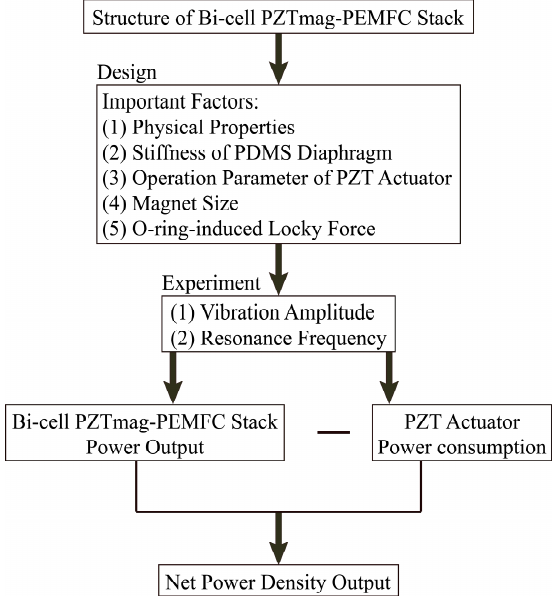
Figure 5. Experiment flowchart of bi-cell PZTmag-PEMFC stack.